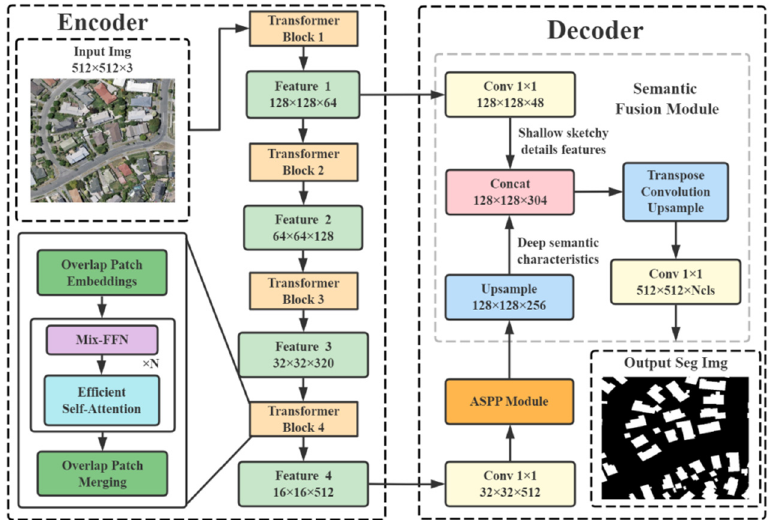
Figure 1. Schematic diagram of the network structure.